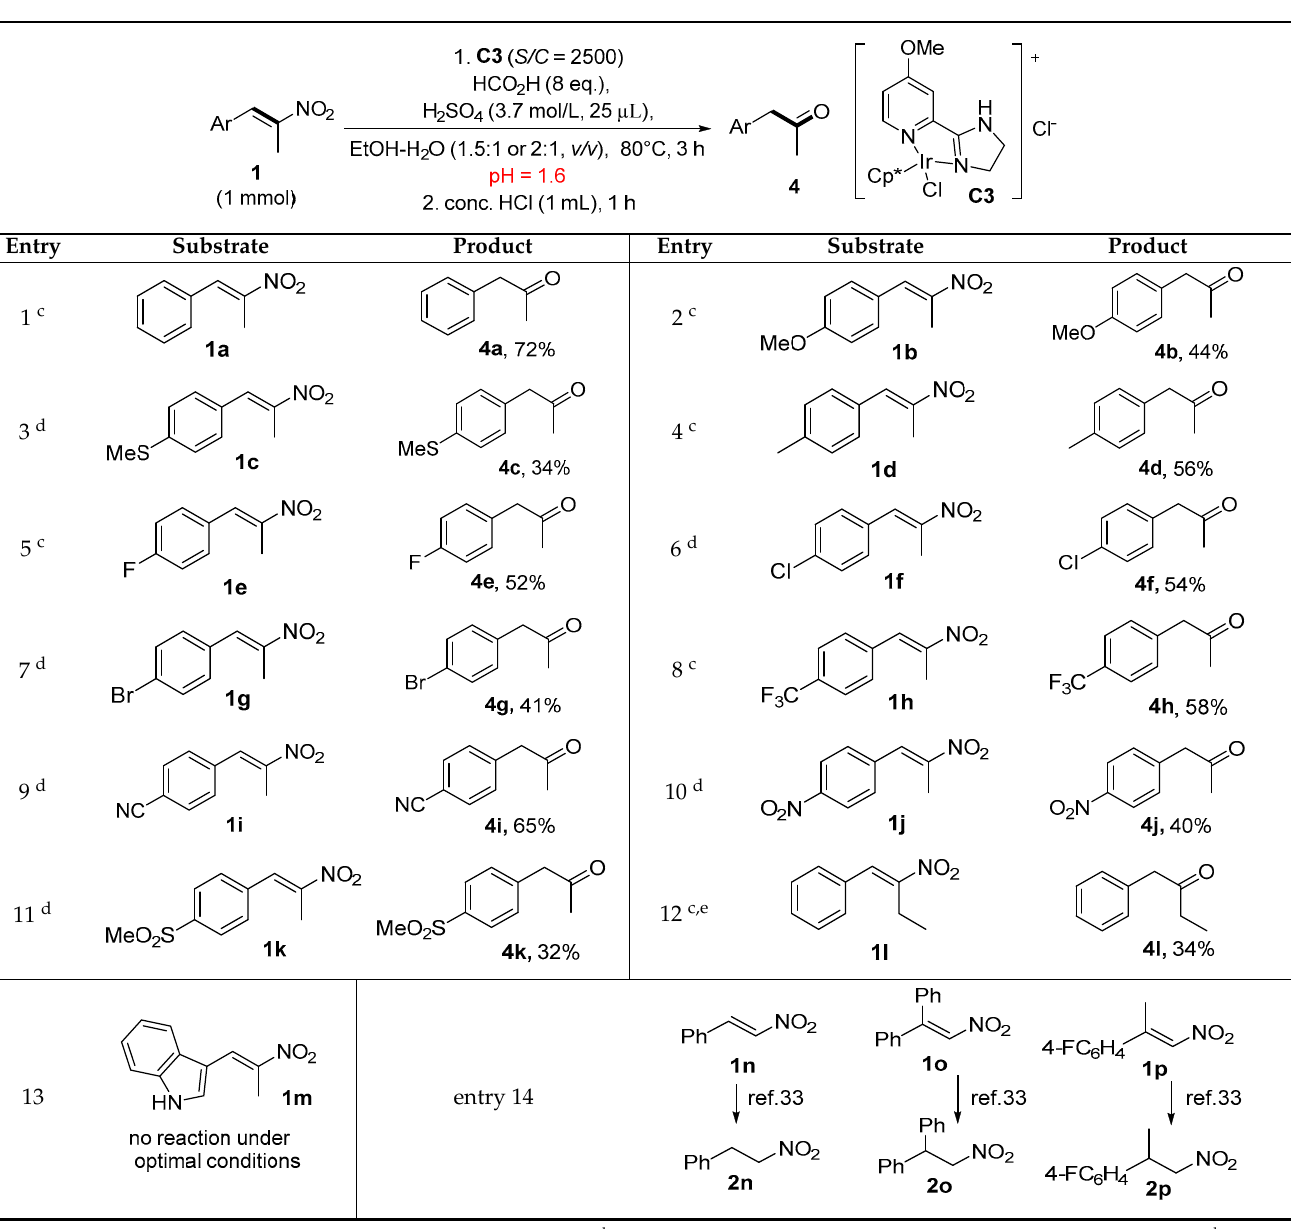
Table 2. Conversion of different nitroalkenes a,b .